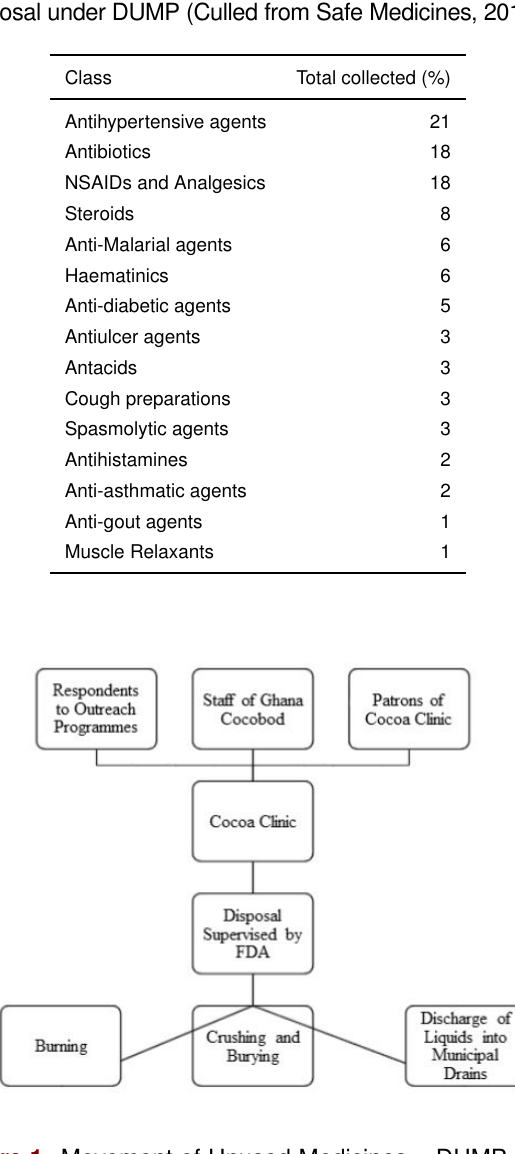
Figure 1. Movement of Unused Medicines – DUMP (dis- tilled from interviews by